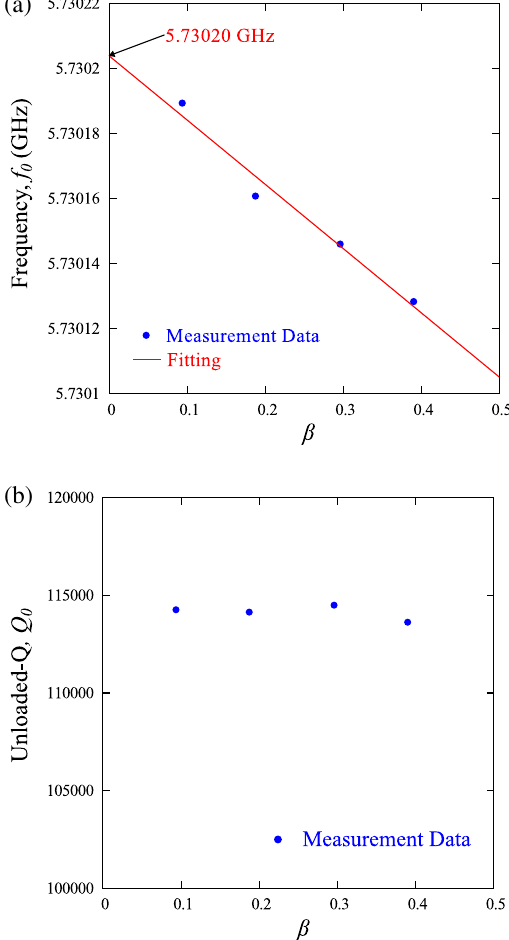
FIG. 6. (a) Frequency dependence of the measured j S 11 j . The horizontal axis indicates the frequency (GHz) and the vertical axis indicates the S 11 in decibel units (dB). (b) The measured S 11 in the format of the Smith chart. The coupling coefficient β was approximately 0.19 during these measurements.